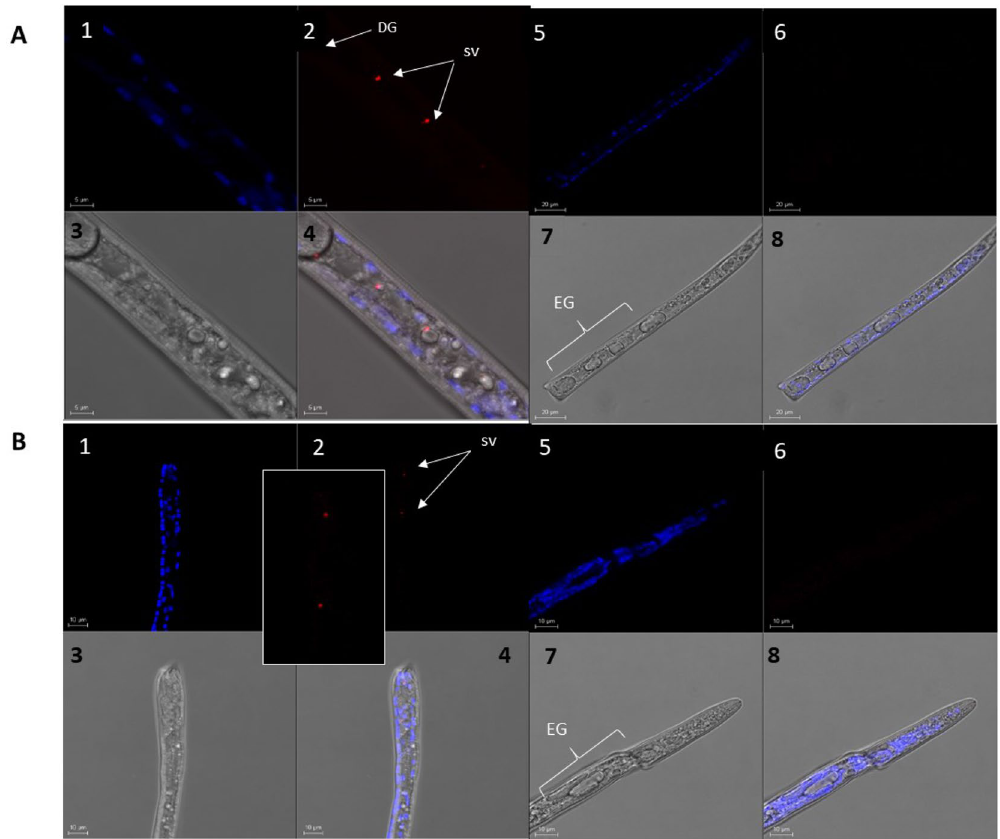
Figure 5. FISH of dissected freshly hatched M. javanica J2 . M. javanica J2 were stained with DAPI (blue) together with ( A ) Triacylglycerol lipase Cy5-specific probe (red). ( A1–4 ) M. javanica J2 exposed to 9-HOT. Esophageal gland area: D, dorsal gland; SV, subventral glands (combined Z sections). ( A5–8 ) M. javanica exposed to 0.01 M MES buffer + ethanol; EG, esophageal gland region. 1 and 5 DAPI-stained nuclei (blue) of the dissected nematode as seen from combined sections under fluorescence. 2 and 6 FISH signal of triacylglycerol lipase Cy5-specific probe (red) as seen from combined sections under fluorescence. 3 and 7 Combined DAPI- stained nuclei (blue) and FISH signal (red) under bright field. 4 and 8 M. javanica as seen from combined sections under bright field and fluorescence. ( B ) MLT-10 like Cy5-specific probe (red). ( B1–4 ) M. javanica J2 exposed to 9-HOT. SV, subventral glands (combined Z sections). ( B5–8 ) M. javanica exposed to 0.01 M MES buffer + ethanol; EG, esophageal gland region. 1 and 5 DAPI-stained nuclei (blue) of the dissected nematode as seen from combined sections under fluorescence. 2 and 6 FISH signal of MLT-10 Cy5-specific probe (red) as seen from combined sections under fluorescence. 3 and 7 Combined DAPI-stained nuclei (blue) and FISH signal (red) under bright field. 4 and 8 M. javanica as seen from combined sections under bright field and